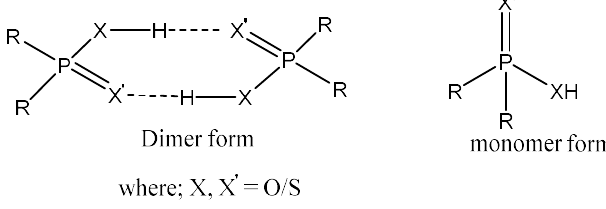
Table 2. Components of Cyanex 272, Cyanex 302 and Cyanex 301 [6].